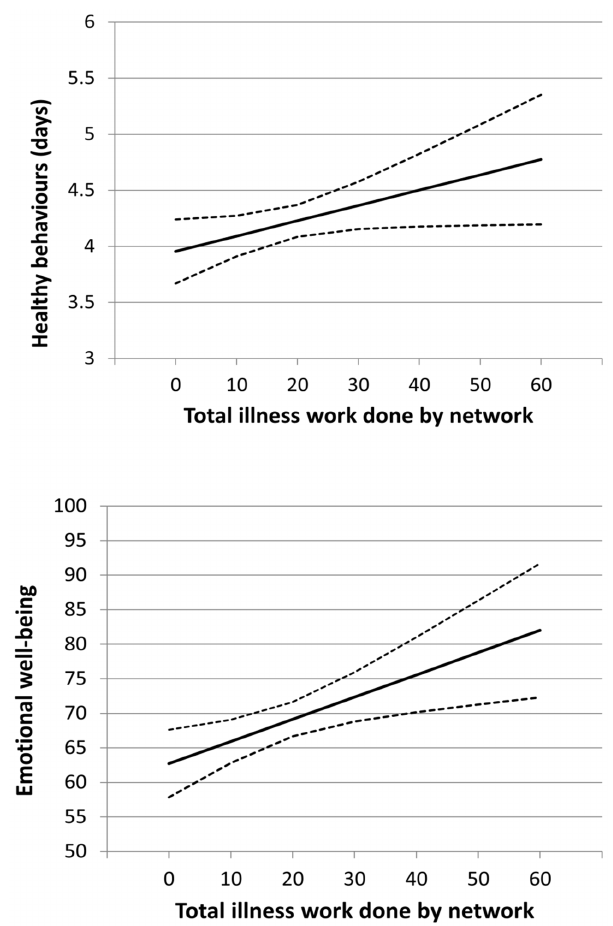
Figure 2. Modelled relationships (mean score and 95% confidence interval) between health behaviour and illness work done by the network, and emotional well-being and illness work done by the network, controlled for patient sociodemographics, disease burden and other significant social network characteristics (Model